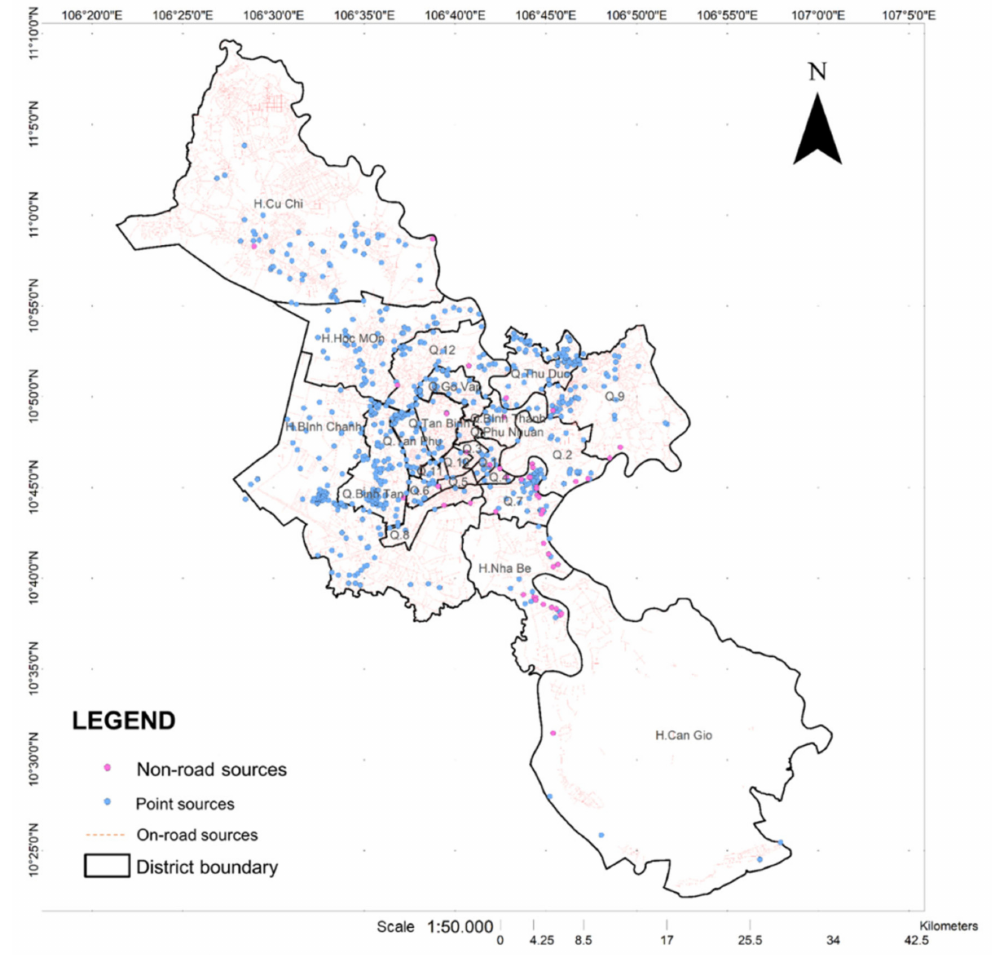
Figure 6. District boundary of Ho Chi Minh City Map and distribution of emissions